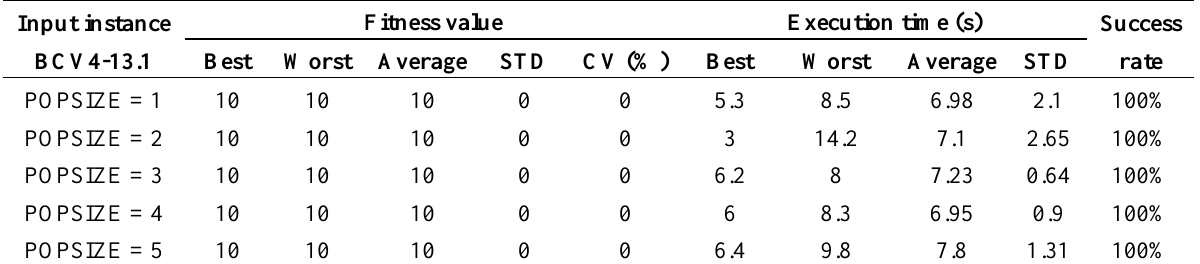
Table 18. Investigating the effect of population size for input instance, BCV4-13.1.